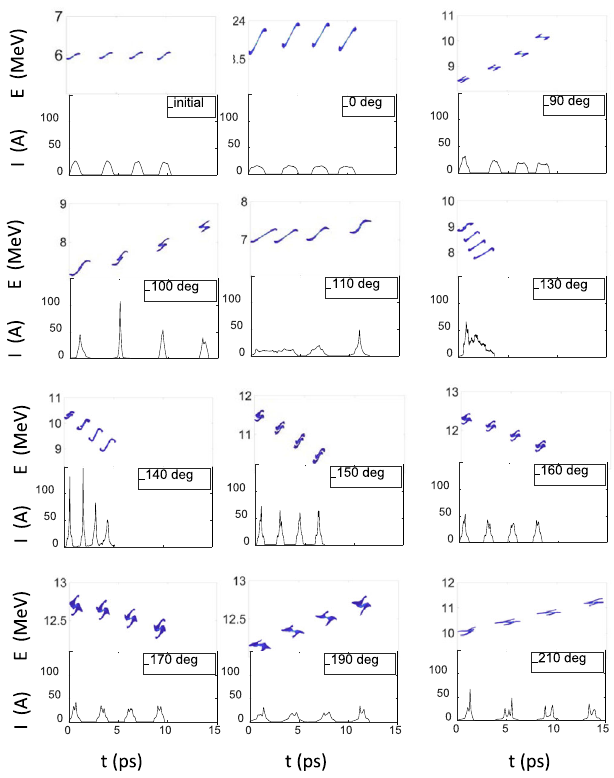
FIG. 9. Low-charge four-bunch case: ASTRA simulations of the longitudinal distributions and phase spaces for the compression of a four-bunch train with different injected phases ϕ 0 , where the charge of each subbunch is 20 pC.